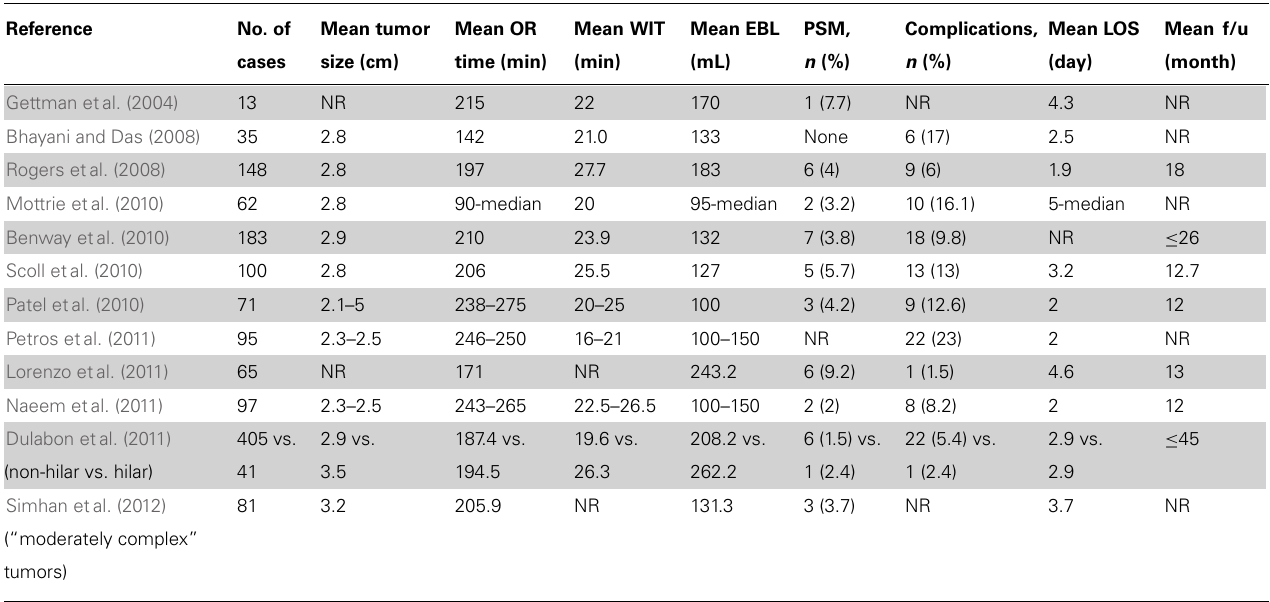
Table 1 | Contemporary robotic partial nephrectomy case